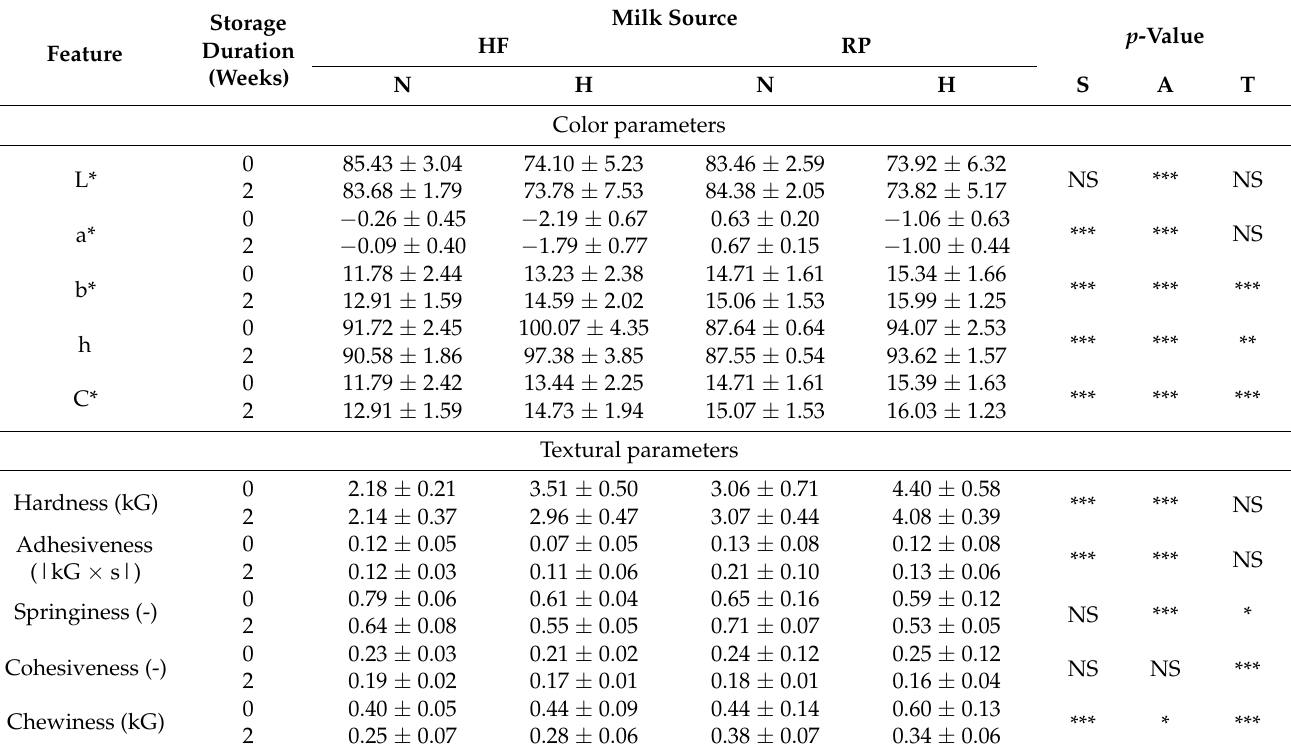
Table 4. Color and textural parameters of the cheeses (mean ±